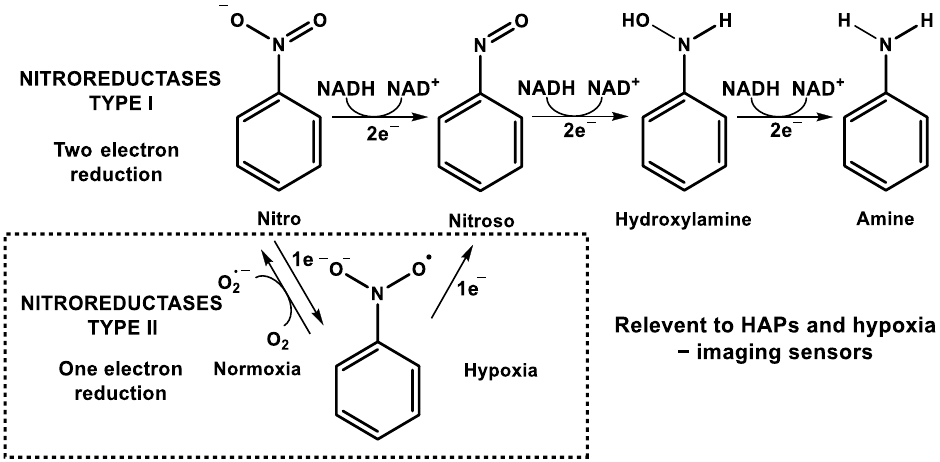
Figure 3. The mechanism of reduction of nitroaromatic compounds by type-I and -II nitroreduc- tases.